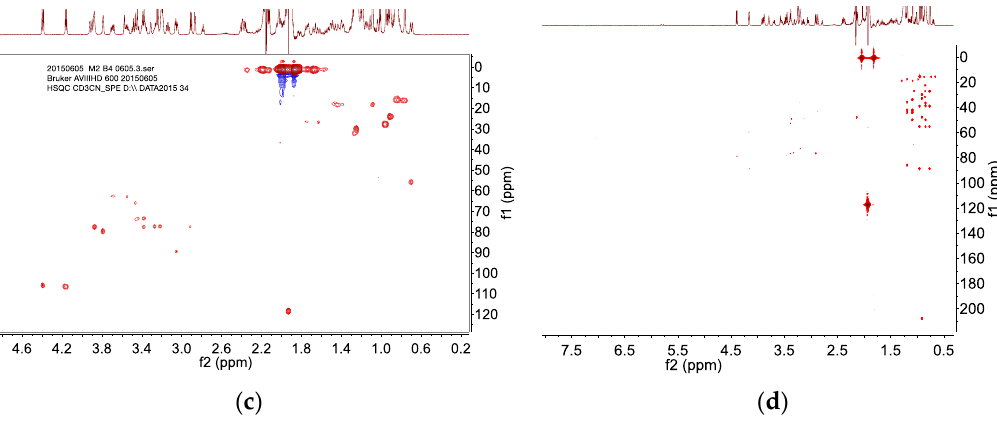
Figure 5. 1 H-NMR ( a ); 1 H-COSY ( b ); HSQC ( c ); and HMBC ( d ) of ADS-I intestinal bacteria metabolite M2.